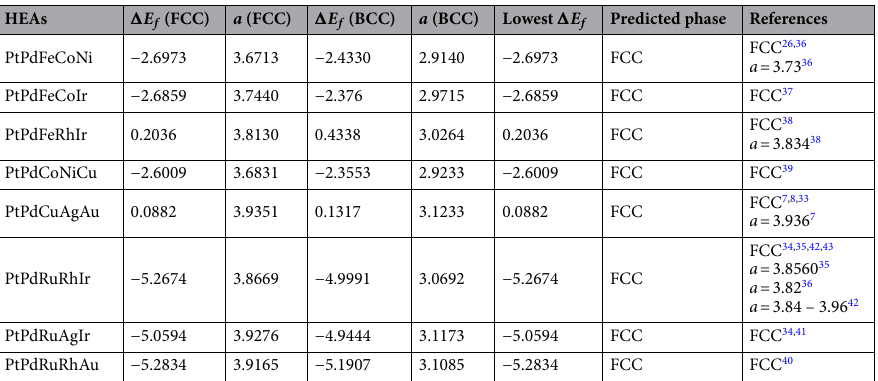
Table 1. Phase classification of PtPd-based HEAs by (cid:31) E f (in kJ mol –1 f.u. –1 ) with a (in Å) validated with literature data.